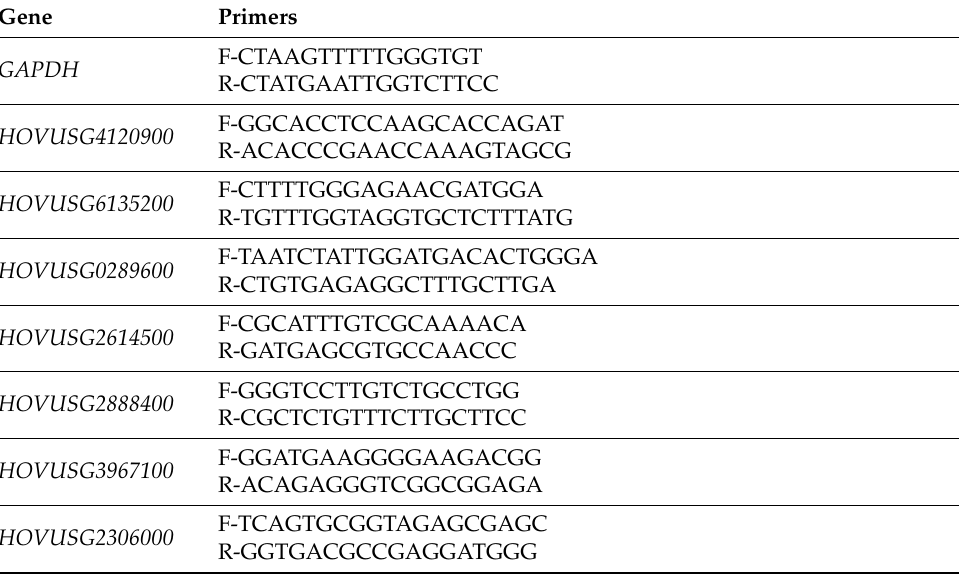
Table 1. List of primers used for quantitative real-time PCR analysis of selected DEGs. Gene